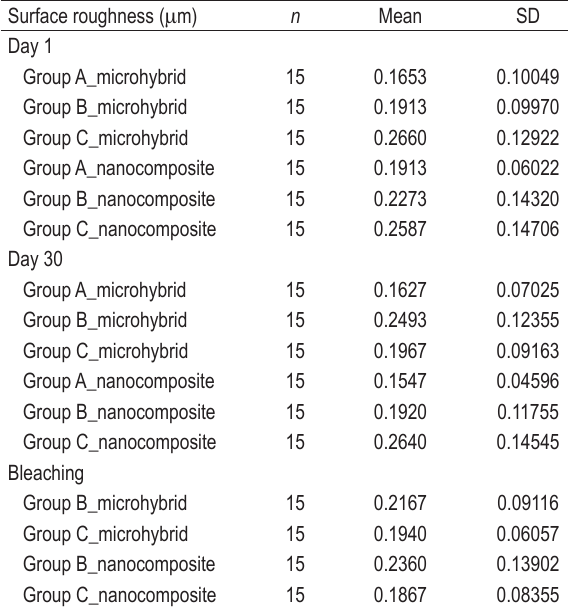
FIGURE 2. Surface roughness measurement with a contact stylus profilometer. TABLE 2. Descriptive statistics of tested composites in different experimental